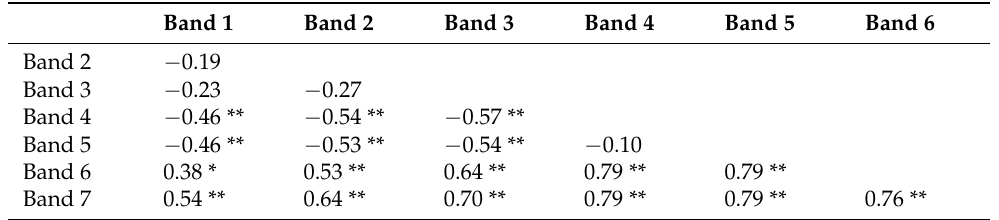
Table 4. Correlation (r) between aboveground carbon content of saltmarsh herbs, grasses, and sedges quadrats with each normalized-difference (ND) ArborCam image (* p < 0.05; ** p < 0.01).